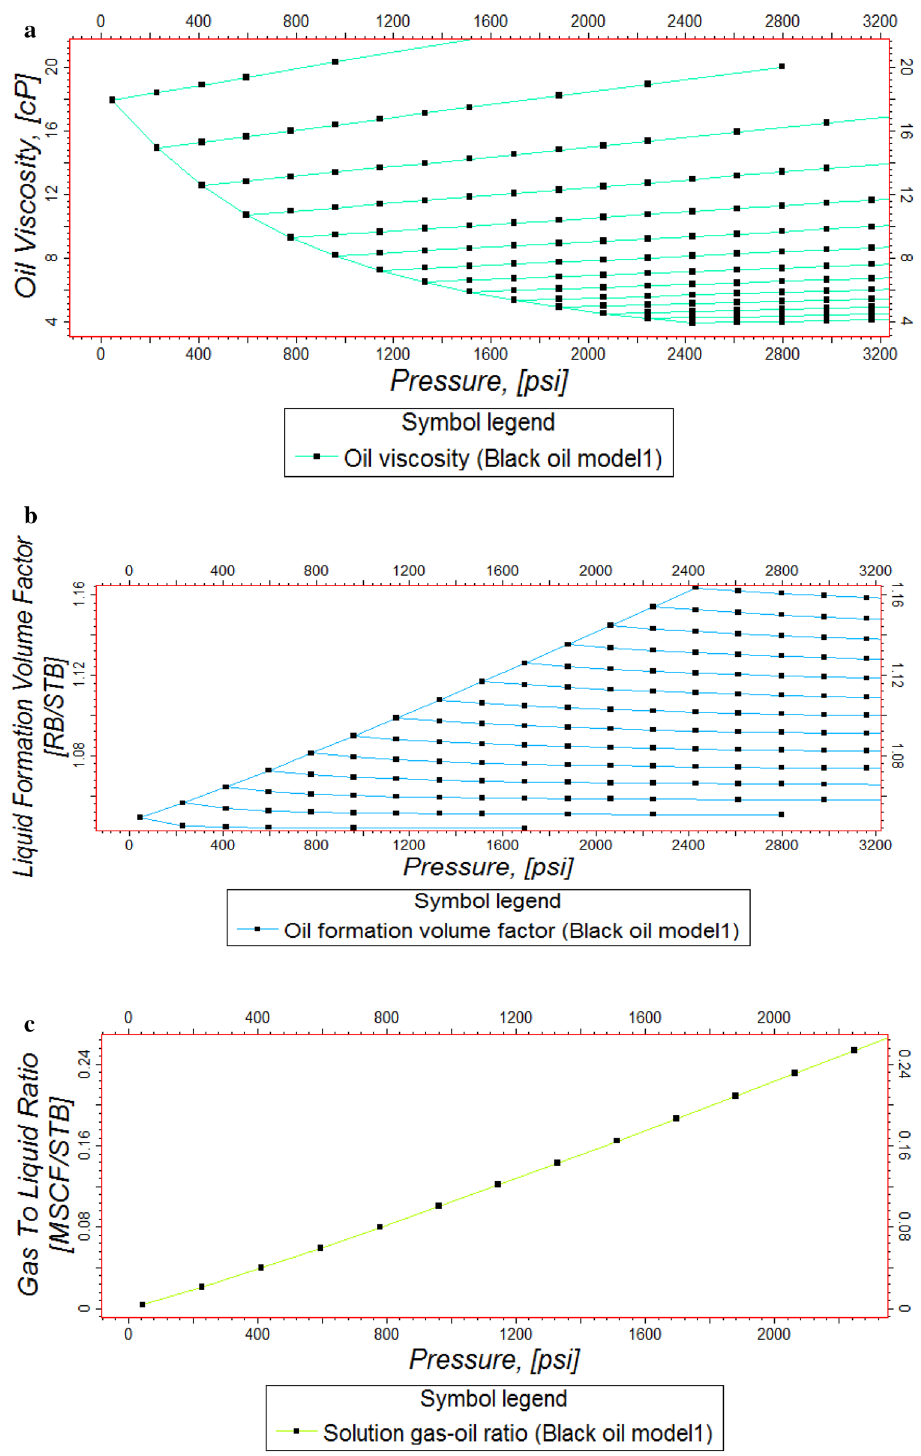
Fig. 7 a Effect of pressure on oil viscosity. b Effect of pres- sure on oil formation volume factor. c Effect of pressure on solution gas oil